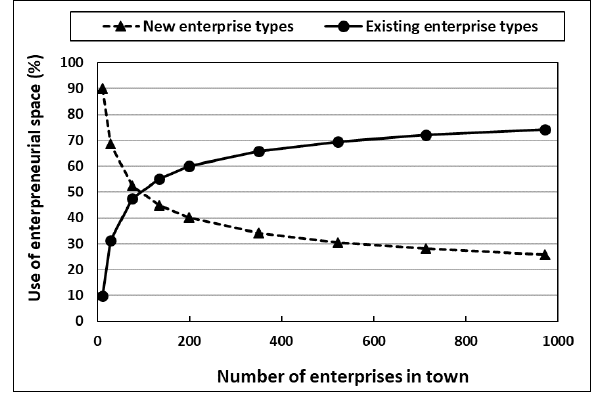
The use of entrepreneurial space in 188 South African